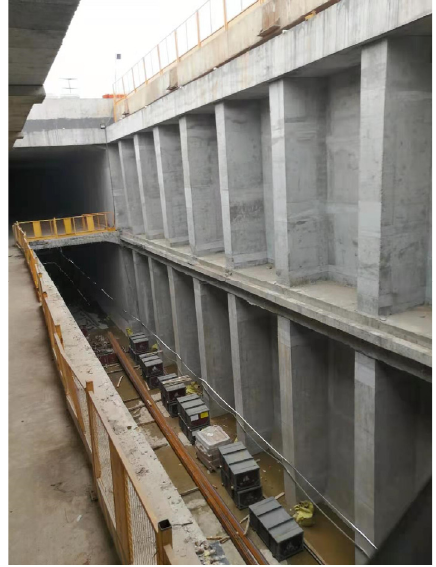
Figure 2. Picture of metro station with reserved large-size openings .